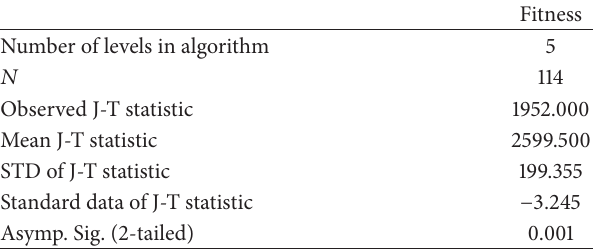
Standard data of J-T statistic Asymp. Sig.